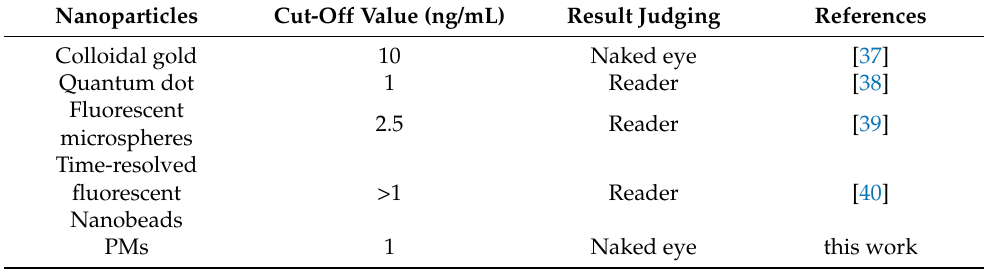
Figure 4. Detection result of AFB 1 in maize samples. vLOD and cut-off value were present by the PMs-ICA, respectively. Table 1. Comparison of performances and convenience of LFICAs for AFB 1 detection.